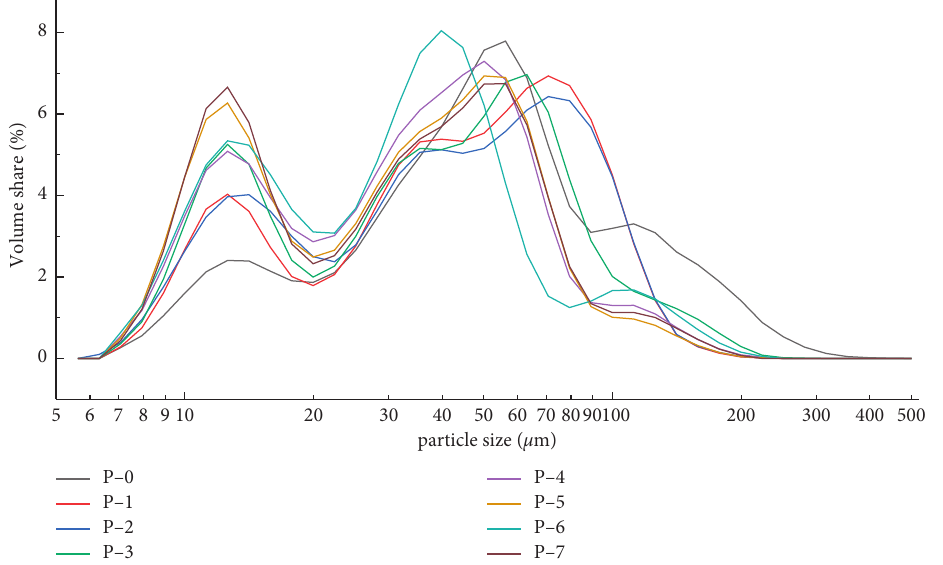
Figure 8: Particle size distribution of PBG.